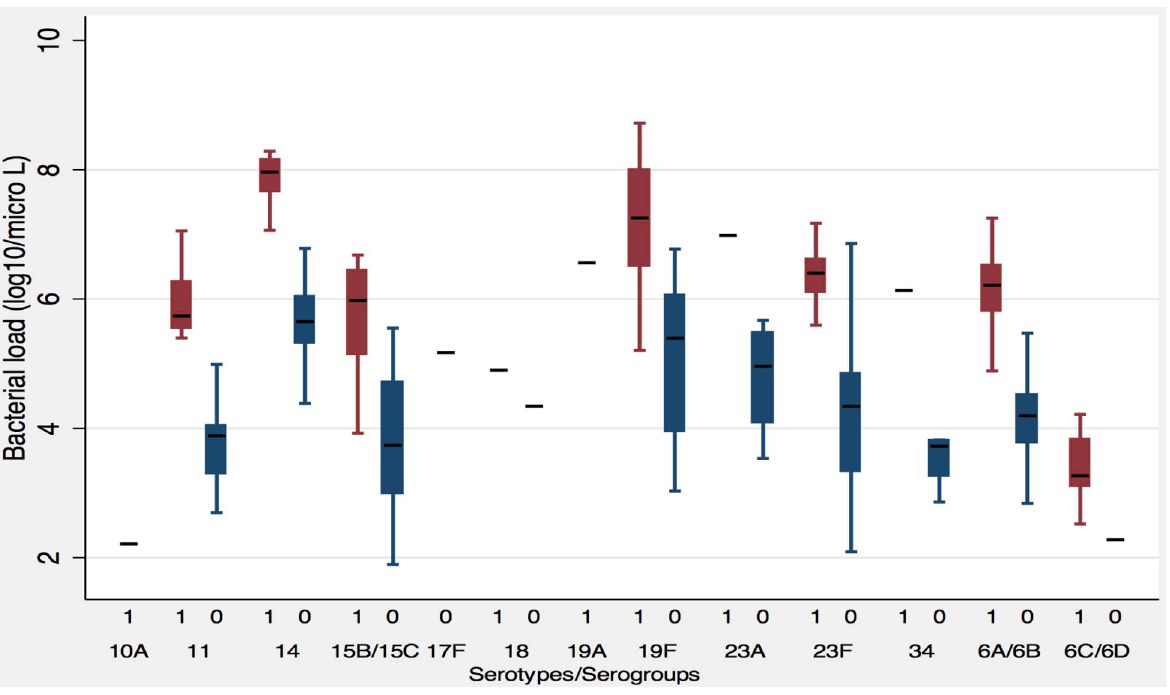
Figure 3. Bacterial load of specific serotypes/serogroups of pneumococcus in ARI cases and healthy children. Bacterial load of ARI cases (denoted by ‘‘1’’ in each serotype/serogroup) in red and healthy children (denoted by ‘‘0’’ in each serotype/serogroup) in blue, showed that the common serotypes 19F, 14, 23F, 6A/6B, 15B/15C had high bacterial load.